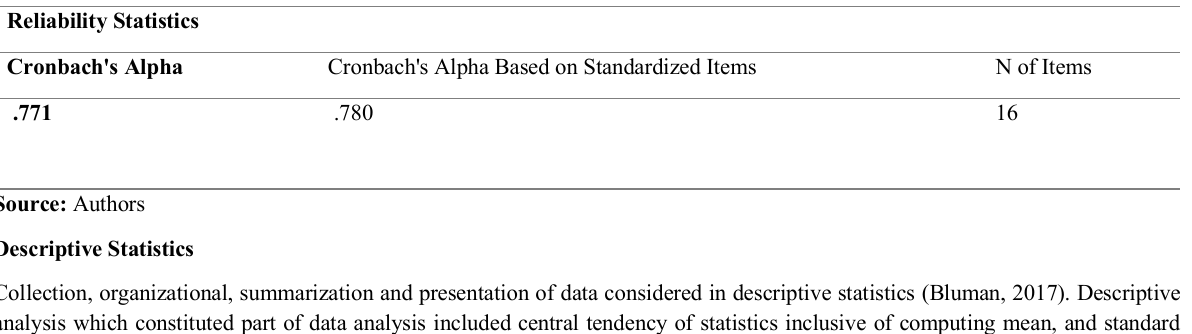
Table 1 : Cronbach's Alpha for Government